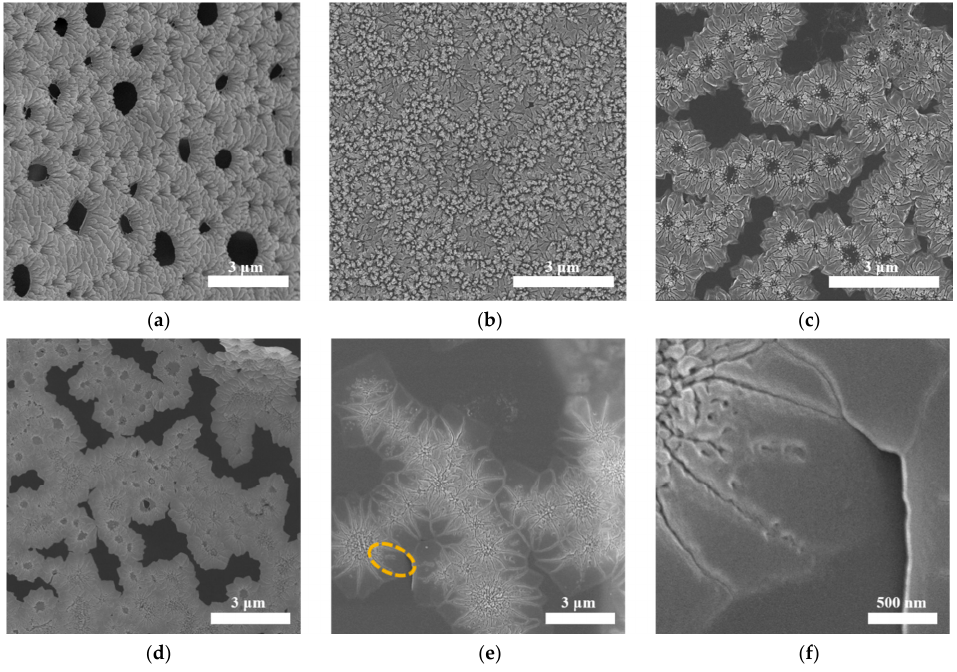
Figure 4. ( a – e ) SEM images of COF-366 film with 0, 10, 20, 60, 100 μ L CNCs, respectively; ( f ) Detailed SEM image of COF-366 film with 100 μ L CNCs.